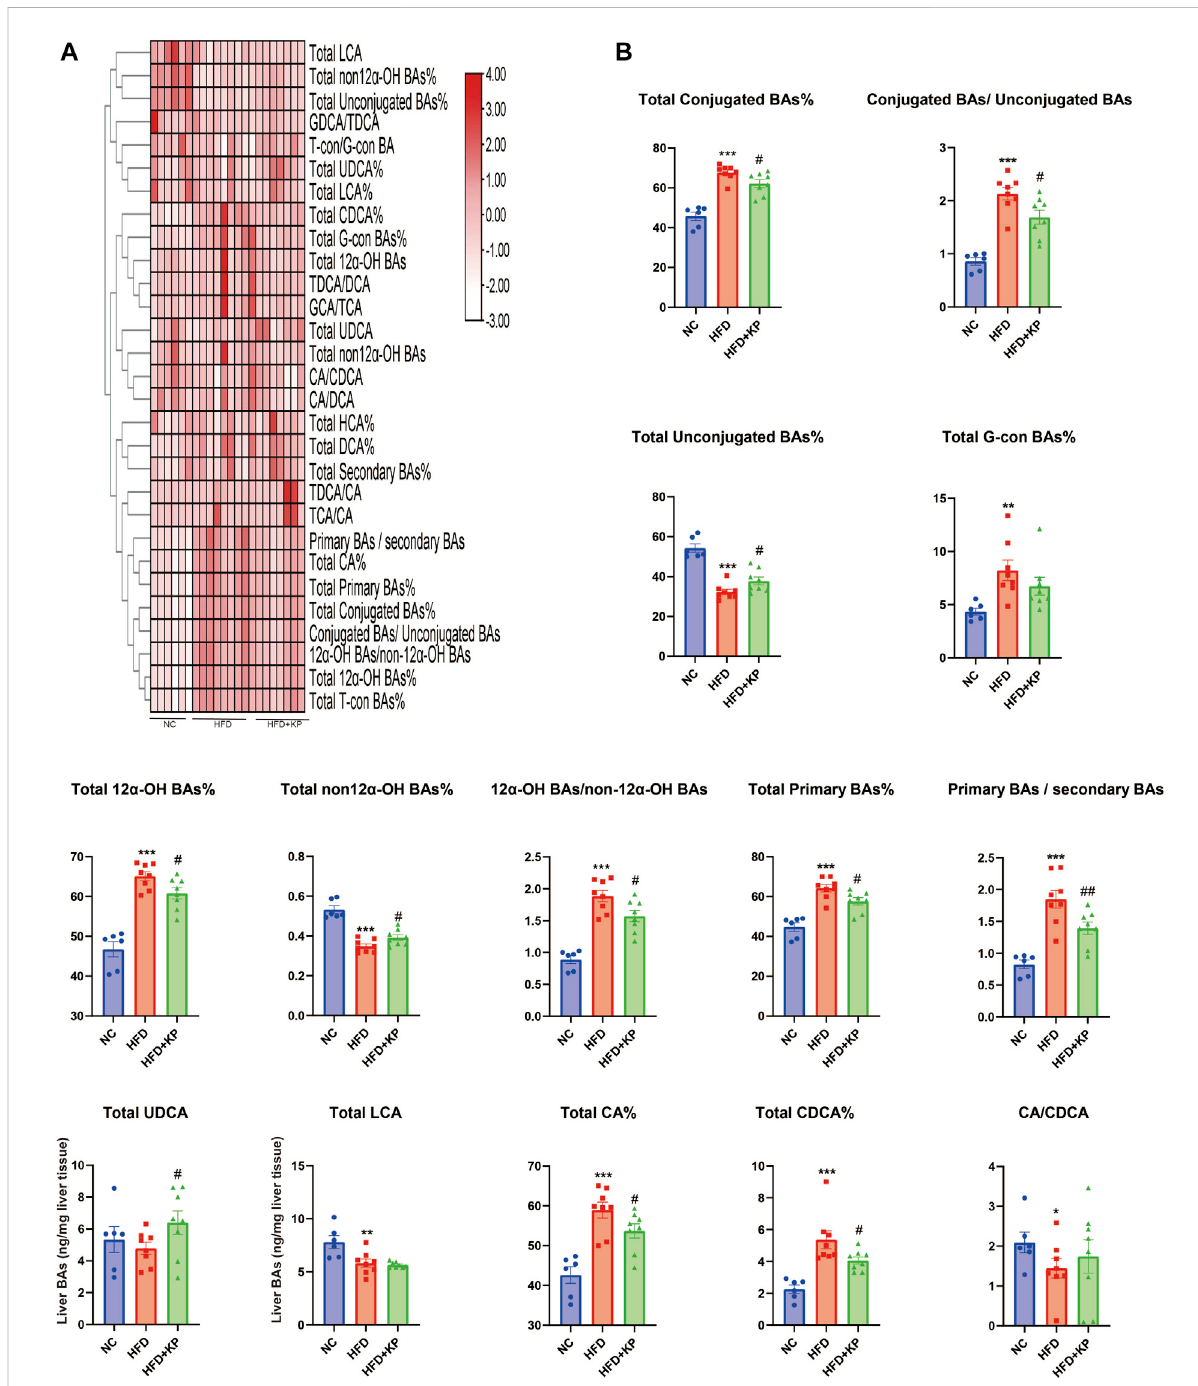
FIGURE 5 Comparison of liver BA ratios and percentage among three groups. (A) Heatmap of liver BA ratios and percentage among three groups. (B) DifferentialliverBAratiossigni fi cantlydifferedamongthreegroups.Allvalueswereexpressedasmean±SEM.* p < 0.05,** p < 0.01,and*** p < 0.001, when NASH models (HFD group) were compared to control groups (NC group); # p < 0.05 and ## p < 0.01, when NASH models (HFD group) were compared to NASH models treated with kaempferol (the HFD + KP